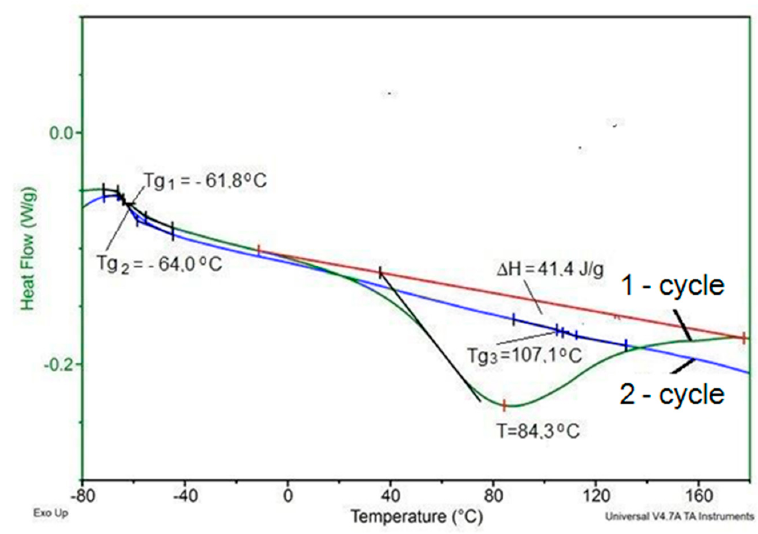
Figure 3. Example of differential scanning calorimetry (DSC) curve for sample R+10K+5F.